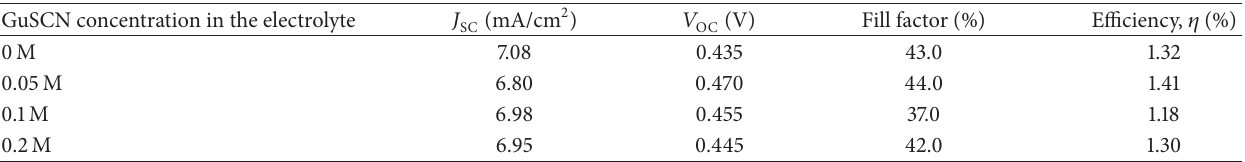
Table 5: Performance parameters of CdSe QDSSC with electrolytes having various amounts of GuSCN additive. Electrolyte used: 0.5 M Na 0.1M S in ethanol/water (8:2 by